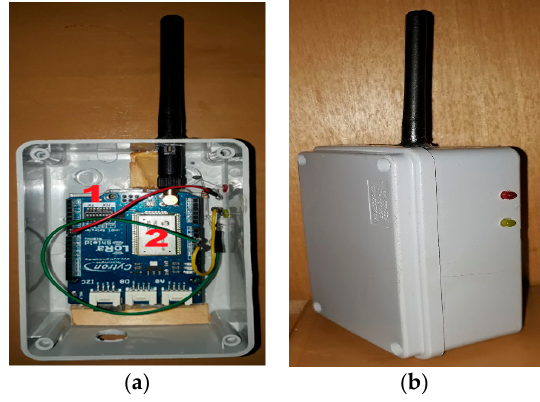
Figure 7. ( a ) Receiver node: (1) Arduino Uno (2) LoRa RN2903 Module. ( b ) The receiver node enclosed inside a weatherproof box.